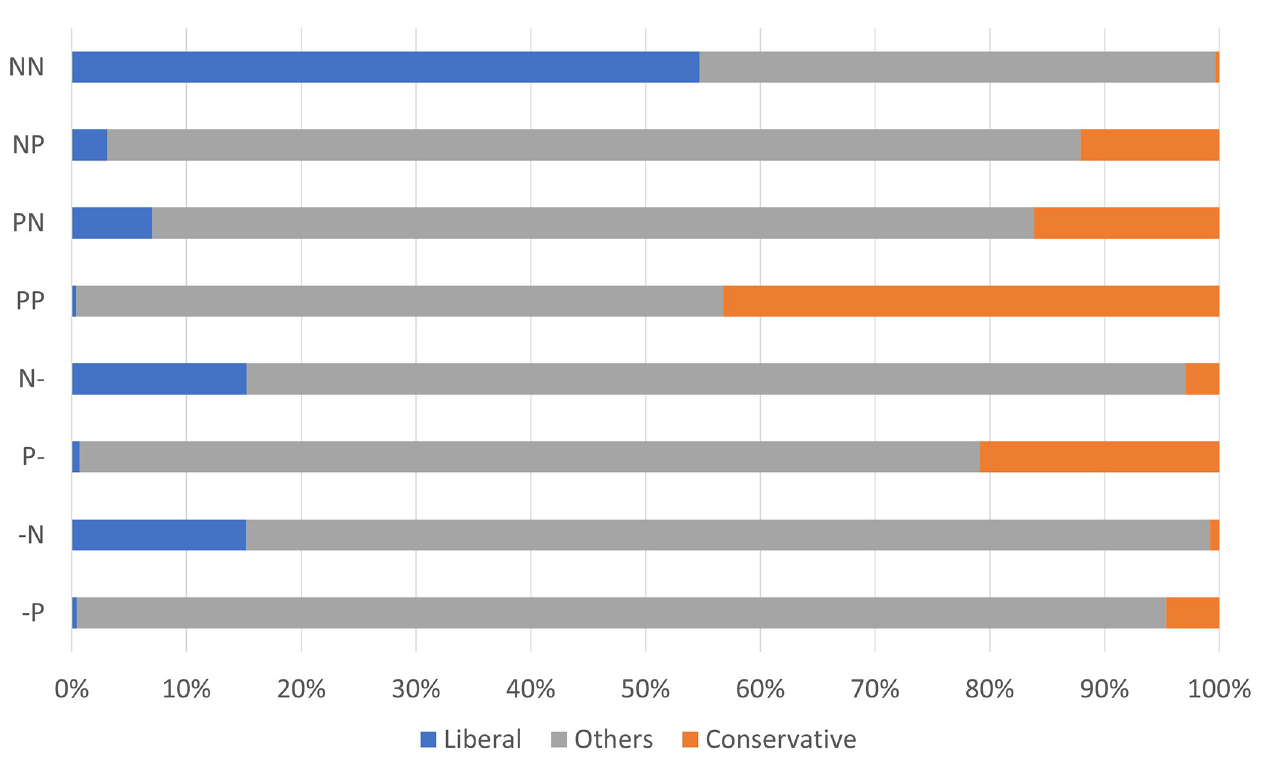
Fig 3. Distribution of political disposition by type of attitude change toward the Olympic